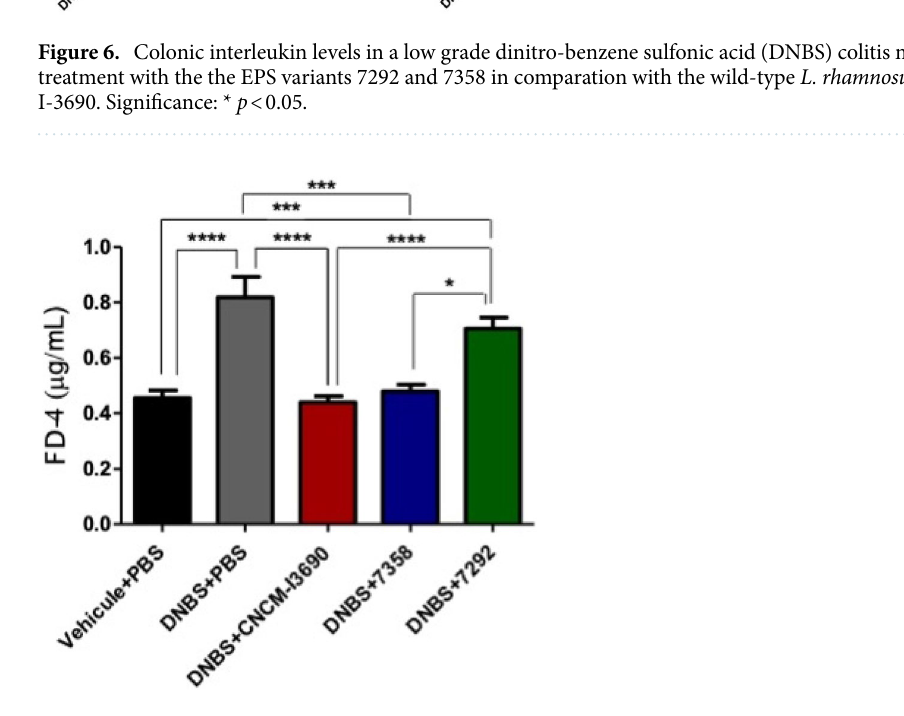
Figure 7. Measure of the in vivo gut permeability in a DNBS low grade murine model after treatment with the EPS variants 7292 and 7358 in comparation with the wild-type L. rhamnosus CNCM I-3690. Significance: * p <